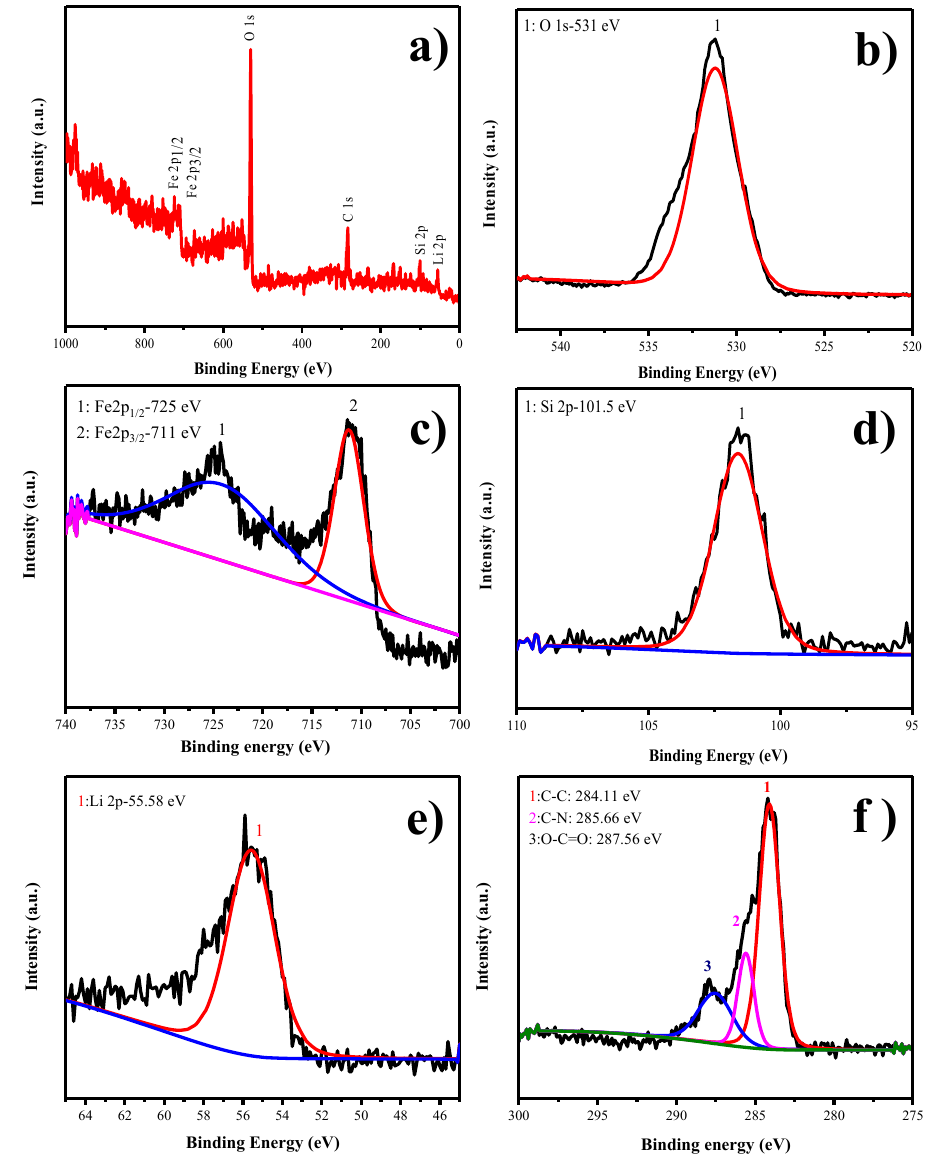
Figure 4. ( a ) Survey, ( b ) O1s, ( c ) Fe2p, ( d ) Si2p, ( e ) Li2s, and ( f ) C1s x-ray photoelectron spectroscopic (XPS) spectra of LFS@ESM.